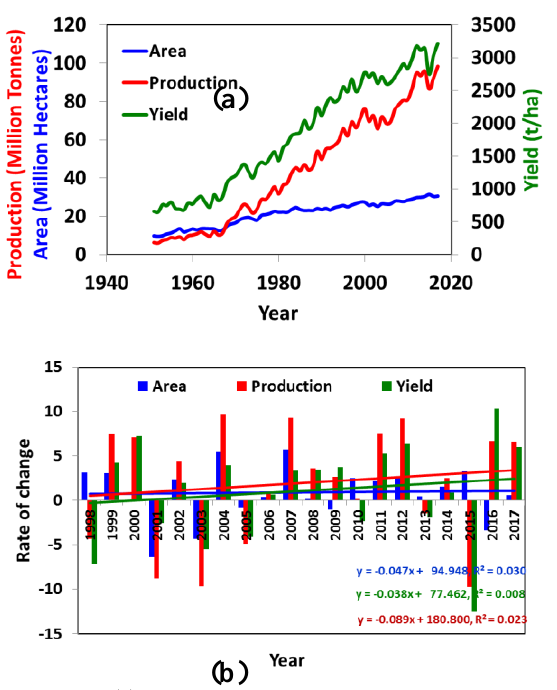
Figure 2 (a) Wheat crop Area, Production and yield in India (b) Rate of change in the Wheat crop Area, Production and yield in